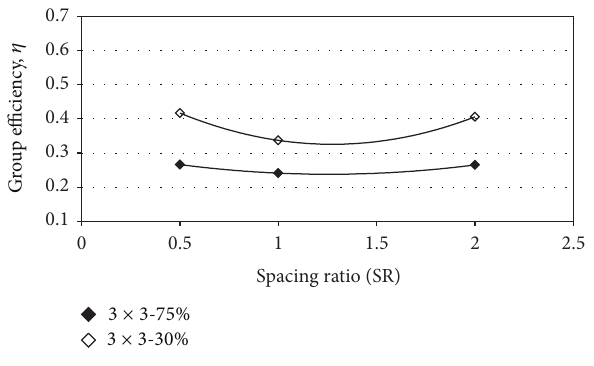
Figure 12: Group efficiency versus spacing ratio of piles; (a) 𝐷 𝐷 𝑟 =75% and (b) 𝑟 =30%.